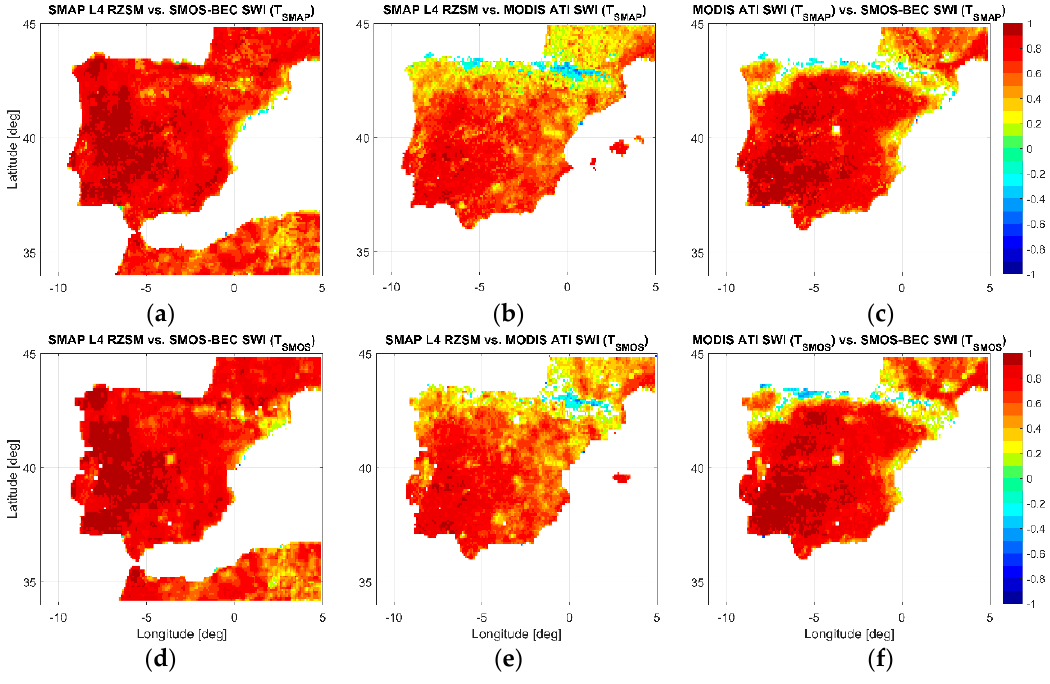
Figure 6. Temporal correlation maps at 9 km between: ( a ) SMAP L4 RZSM and SMOS-BEC SWI (T SMAP ); ( b ) SMAP L4 RZSM and MODIS ATI SWI (T SMAP ); ( c ) MODIS ATI SWI (T SMAP ) and SMOS-BEC (T SMAP ); ( d ) SMAP L4 RZSM and SMOS-BEC SWI (T SMOS ); ( e ) SMAP L4 RZSM and MODIS ATI SWI (T SMOS ); and ( f ) MODIS ATI SWI (T SMOS ) and SMOS-BEC (T SMOS ).